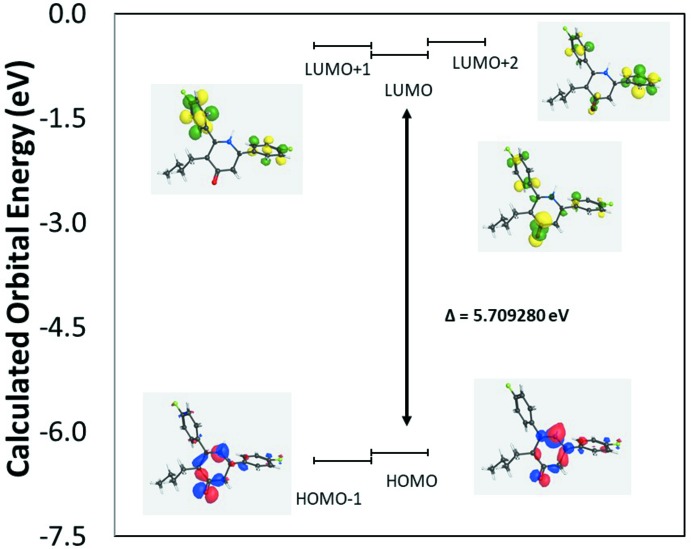
Schematic MO diagram.